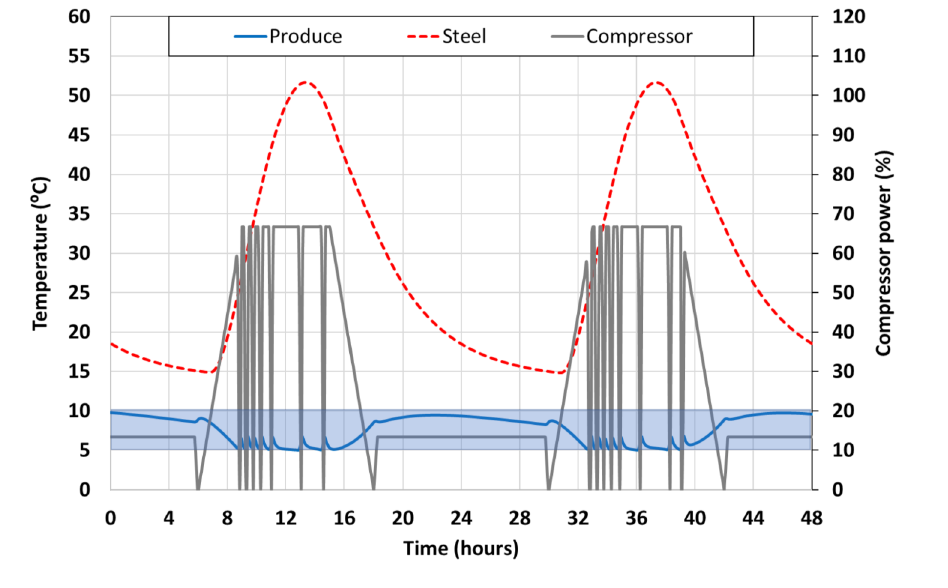
Figure 23. Produce temperature with a 66% increase in the insulation properties of the insulation